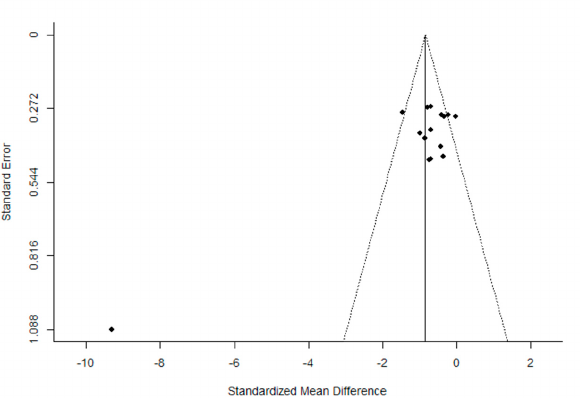
Figure 2. Funnel plot of the meta-analysis of the published studies. Each plotted point represents the standard error (SE) and the standardized mean difference (SMD) between post-intervention urinary loss in women who received PFMT.